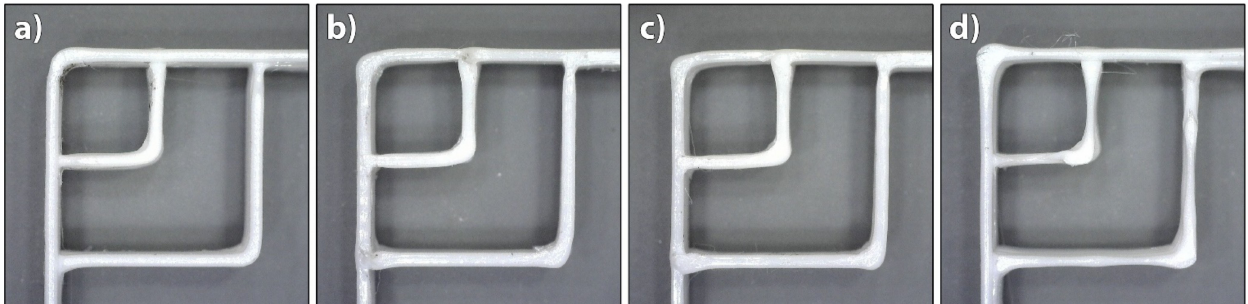
Figure 4. Images of 3D printed PLA test samples printed at different printing speeds: ( a ) 10 mm/s,